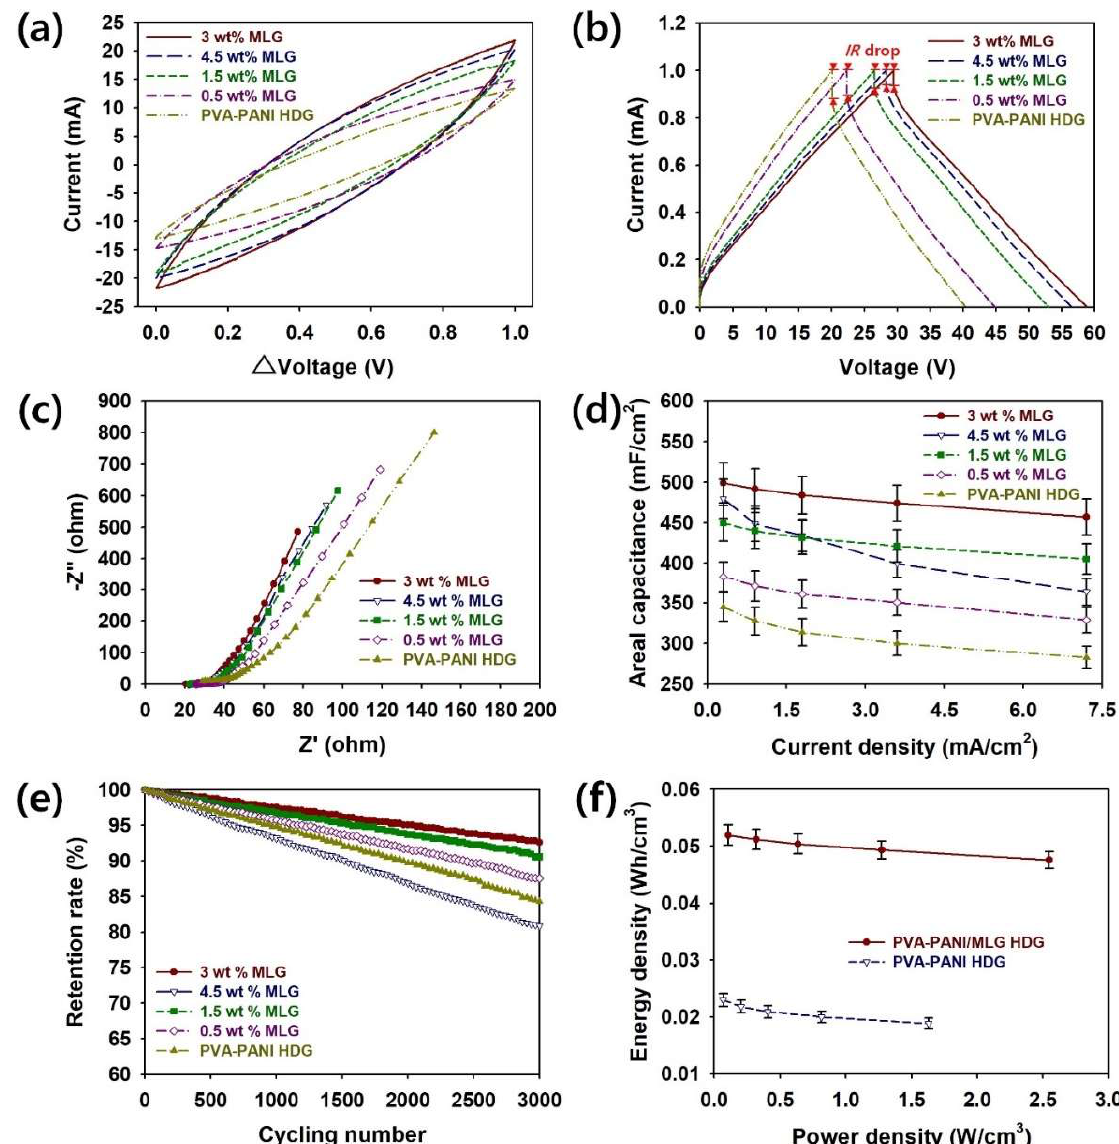
Figure 6. ( a ) CV curves, ( b ) GCD curves, ( c ) Nyquist plots, ( d ) rate capability curves, ( e )